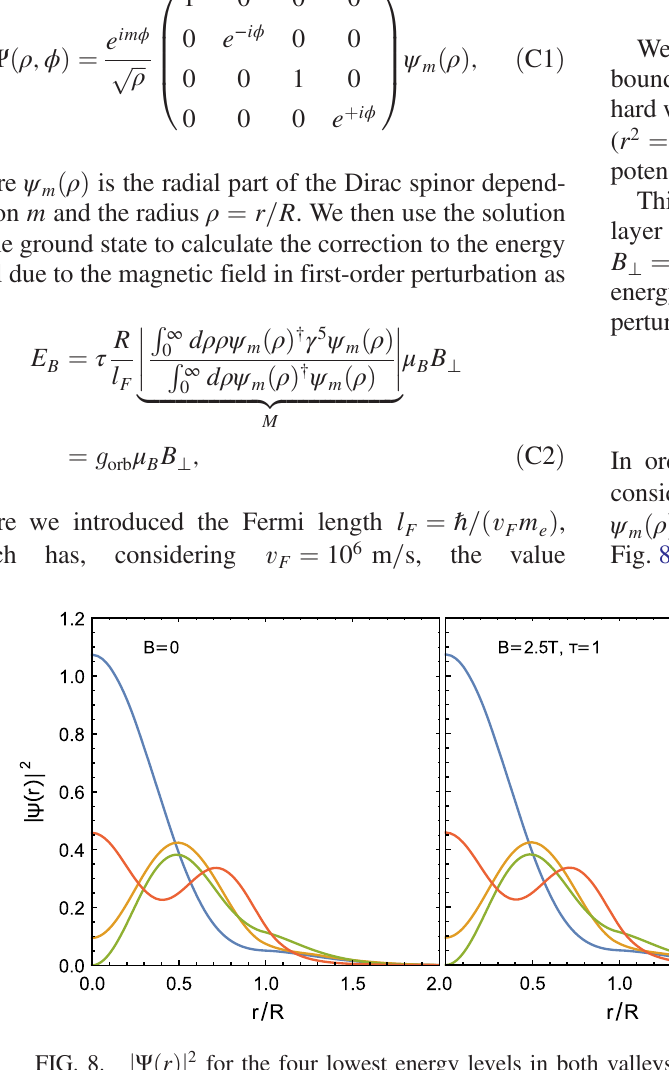
FIG. 8. j Ψ ð r Þj 2 for the four lowest energy levels in both valleys considering R ¼ 20 nm and U ¼ V ¼ 60